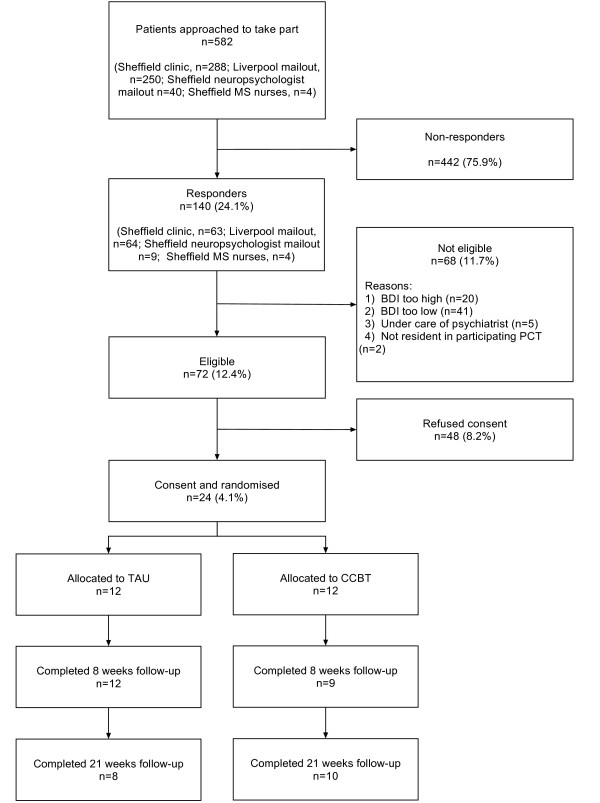
CONSORT diagram.